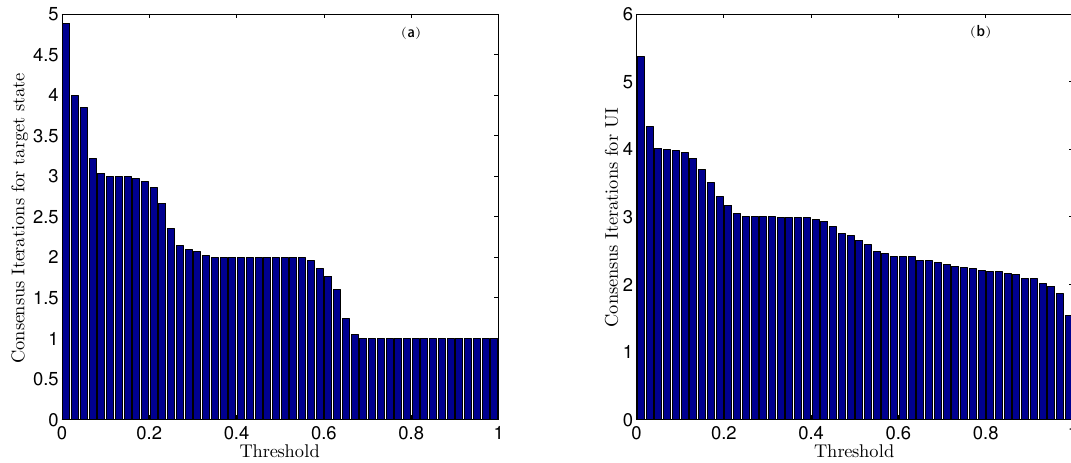
Figure 13. The mean numbers of iteration steps for ( a ) state and ( b ) UI estimation with different thresholds in the multi-sensor system of 60